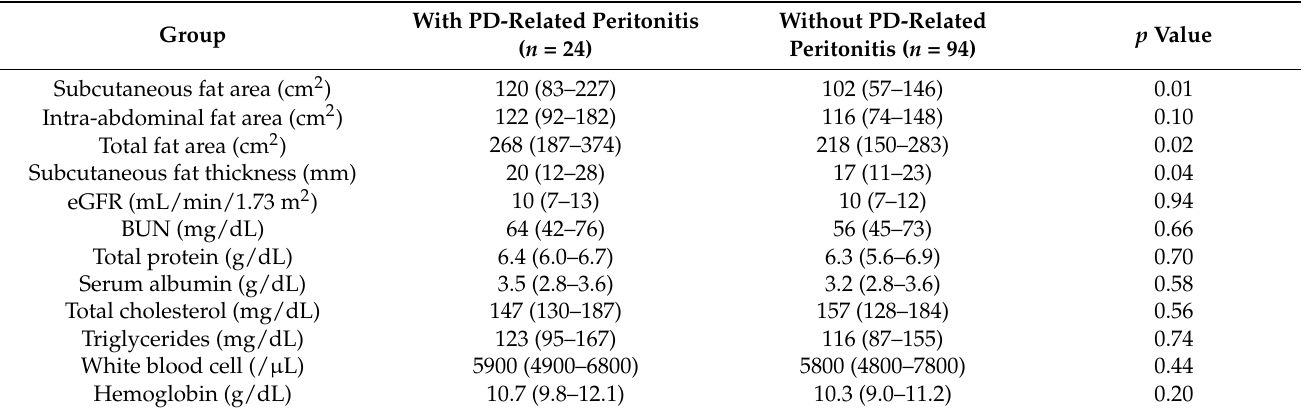
Table 3. Predictive factors for peritoneal dialysis-related peritonitis.